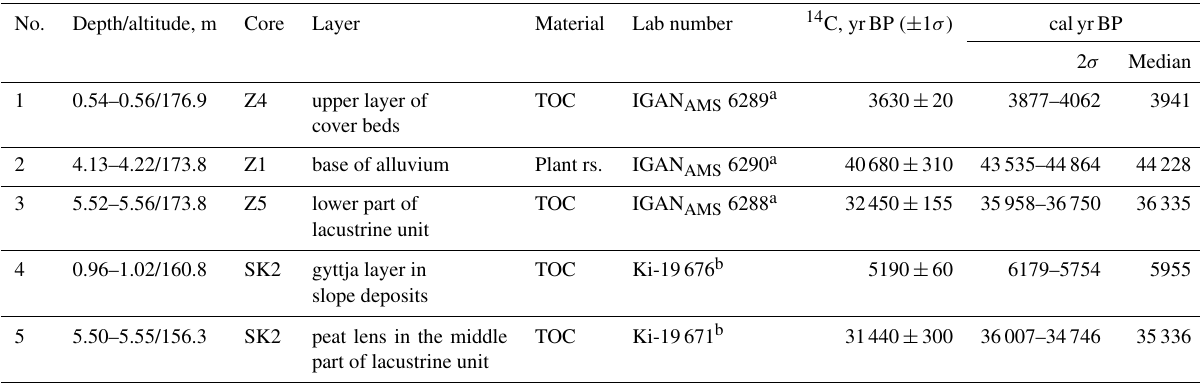
Table 2. AMS 14 C dating results from the meridional depression key site and corresponding calibrated ages.